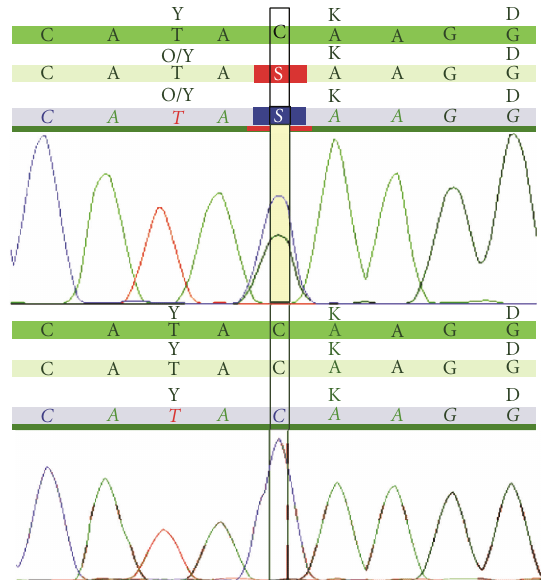
Figure 2: Electropherogram of molecular analysis in the patient sample. The upper panel shows the heterozygous c.1965C > G (p.Tyr652X) mutation and the lower panel shows the wild type (control). The “S” on the electropherogram represents the C/G